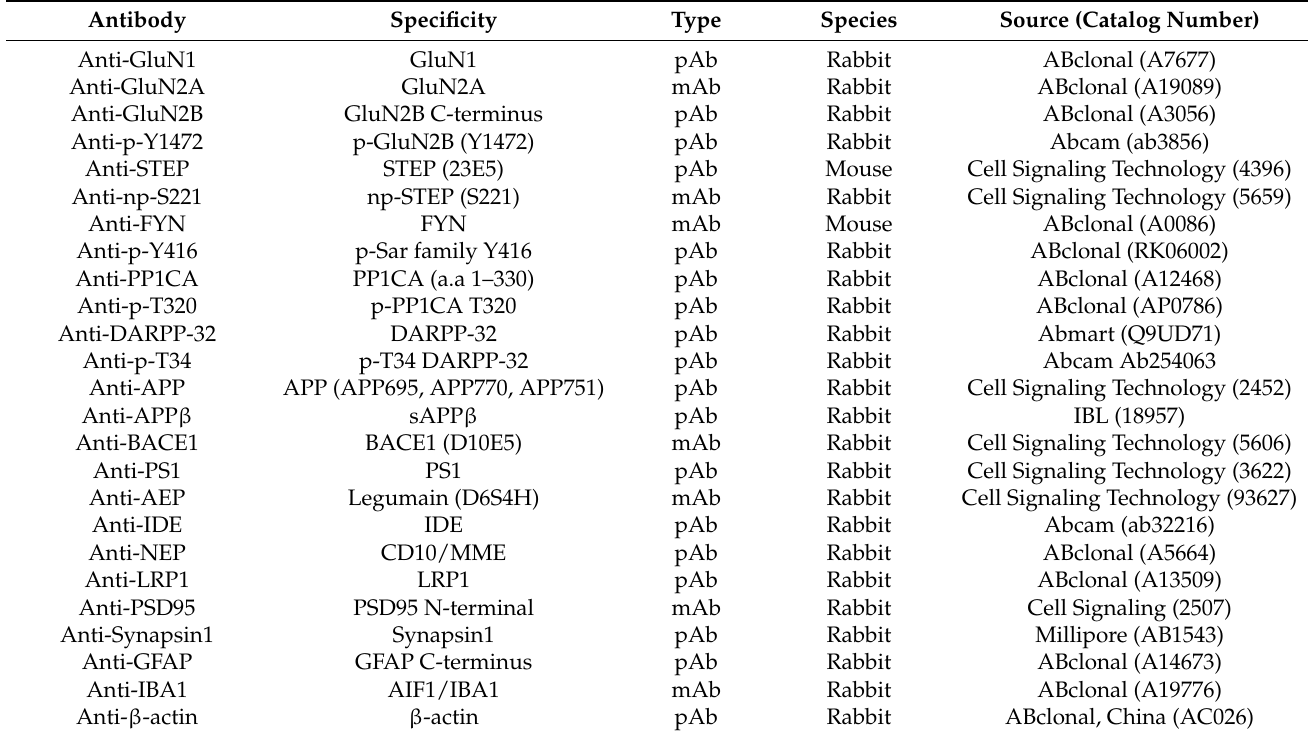
Table 1. The primary antibodies used in this